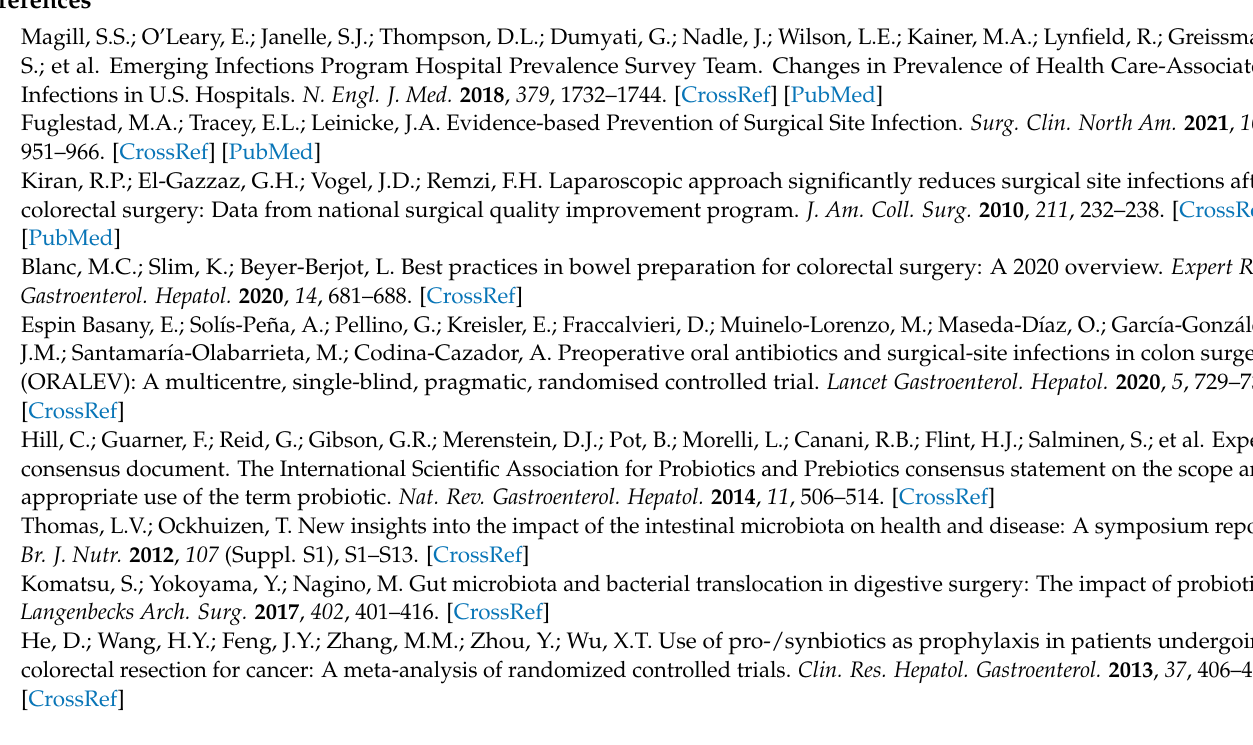
Figure S2: Forest plot of urinary infections [26,29,32,36,37,43], Figure S3: Forest plot of anastomotic leaks [26,28,31,32,34–37,39,41,43], Figure S4: Forest plot of wound infections [24–26,31,34–39,42], Figure S5: Forest plot of probiotics [26–28,31–33,35–37] and synbiotics [24,34,40] subgroups, Figure S6: Forest plot of placebo [26–28,32,36,37,40] and standard care [24,31,33–35] for overall infectious complications, Figure S7: Forest plot of placebo [28,32,36–39] and standard care [24,31,34,35,41] for surgical site infections, Figure S8: Forest plot of infectious complications according to the Jadad score ( ≥ 3) [24,26–28,32–37,40], Figure S9: Forest plot of overall infectious complications according to ethnicity (Asia [26,28,31,34–37]; Occident [24,27,32,33,40]), Figure S10: Forest plot of overall